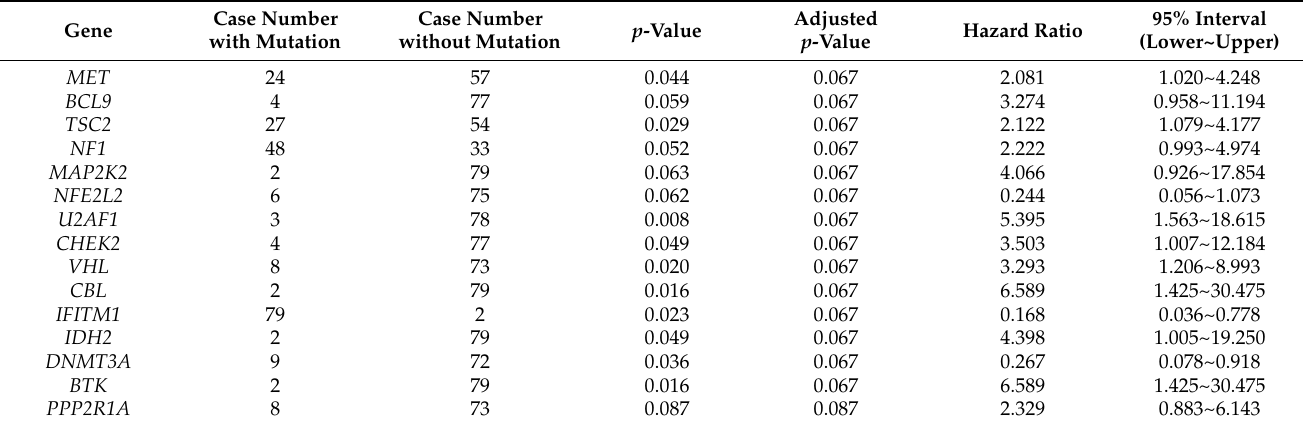
Table 2. The association between the mutated genes and progression-free survival.